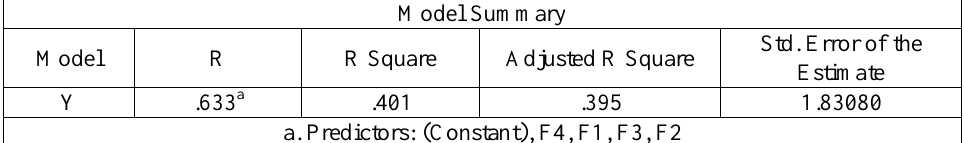
Table. 7. Findings of Regression Test related to Research Hypotheses